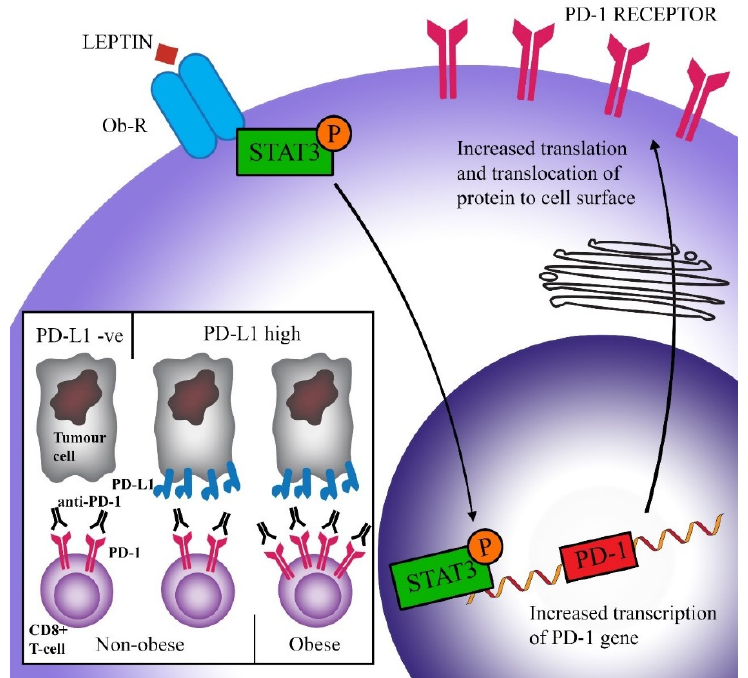
Figure 2. Scheme of a proposed pathway causing increased efficacy of immune checkpoint blockade in obese patients. Leptin binds to its receptor (Ob-R) on CD8 + T-cells and causes the activation (via phosphorylation) of the transcription factor STAT3. STAT3 triggers the transcription of the PD-1 gene and subsequent expression of the PD-1 protein on the cell surface. Higher PD-1 levels are correlated with increased exhaustion (activation by PD-L1 reduces T-cell proliferation, survival, and production of cytokines). However, increased PD-1 expression facilitates greater success of anti-PD-1 therapy, leading to increased overall survival in obese patients.